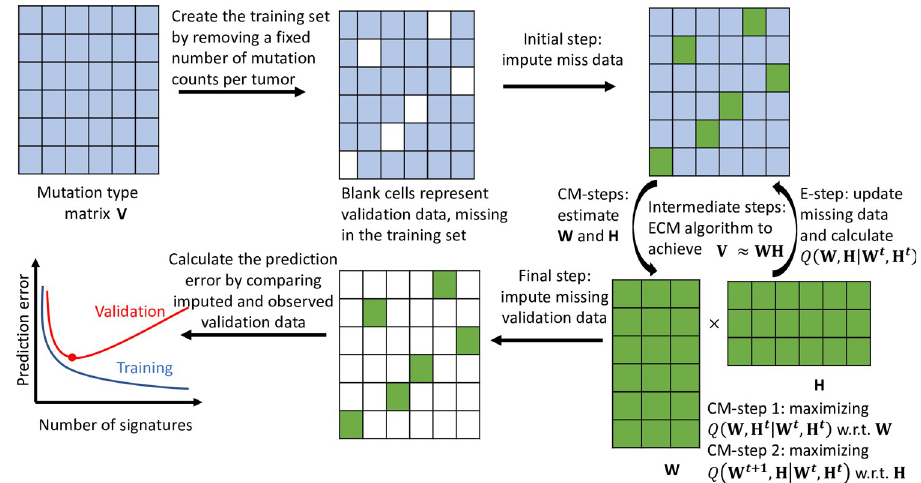
novo mutational signatures. Details are given in Results. Each column of the mutation type matrix V represents a tumor, each row a mutation type. The bottom left shows prediction error curves in the training set (blue) and validation set (red), which are manually drawn for the illustration purpose, with the red dot representing the minimal prediction error in the validation set. ECM algorithm: expectation/conditional maximization algorithm;